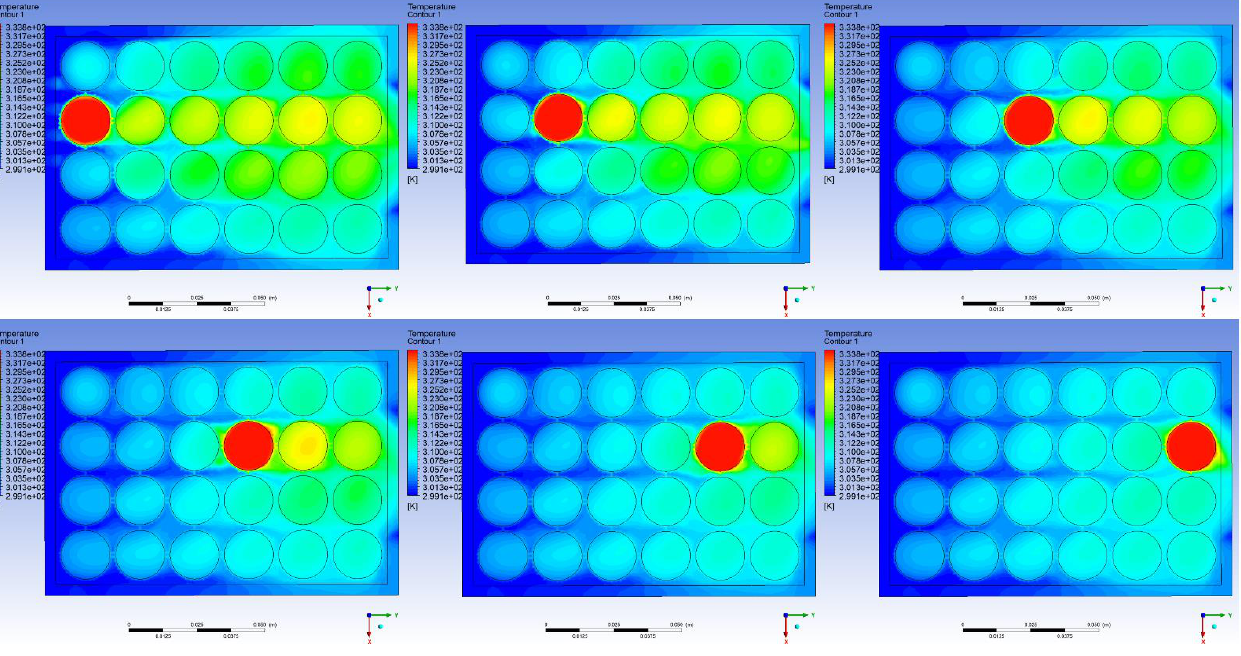
Figure 7. Comparison of the temperature distributions among the applied abnormal heat generation on different cells in Row 2.